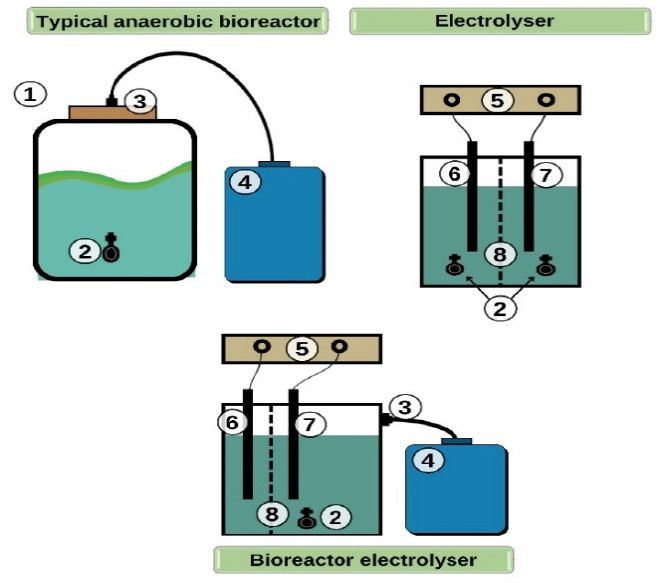
Figure 2. Lab-benches used for biogas production stimulation: 1—anaerobic bioreactor, 2—sam- pling tap, 3—biogas outlet tap, 4—gas holder, 5—power source, 6—anode, 7—cathode, 8—mem- tap, 3—biogas outlet tap, 4—gas holder, 5—power source, 6—anode, 7—cathode, brane.and